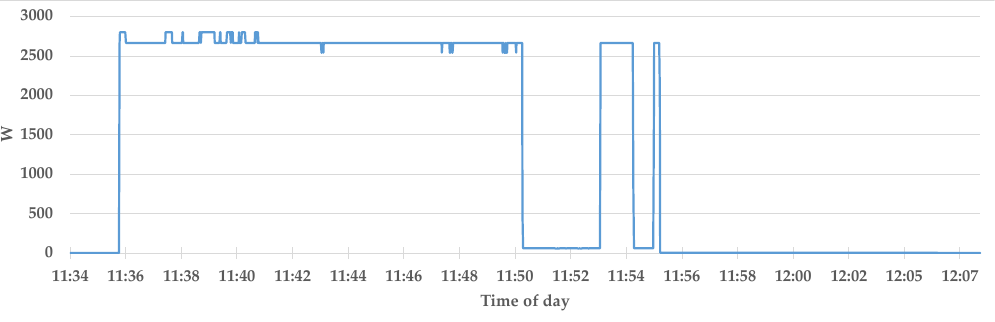
Figure 19. Load profile of the electric oven. Table 3. Appliances used for